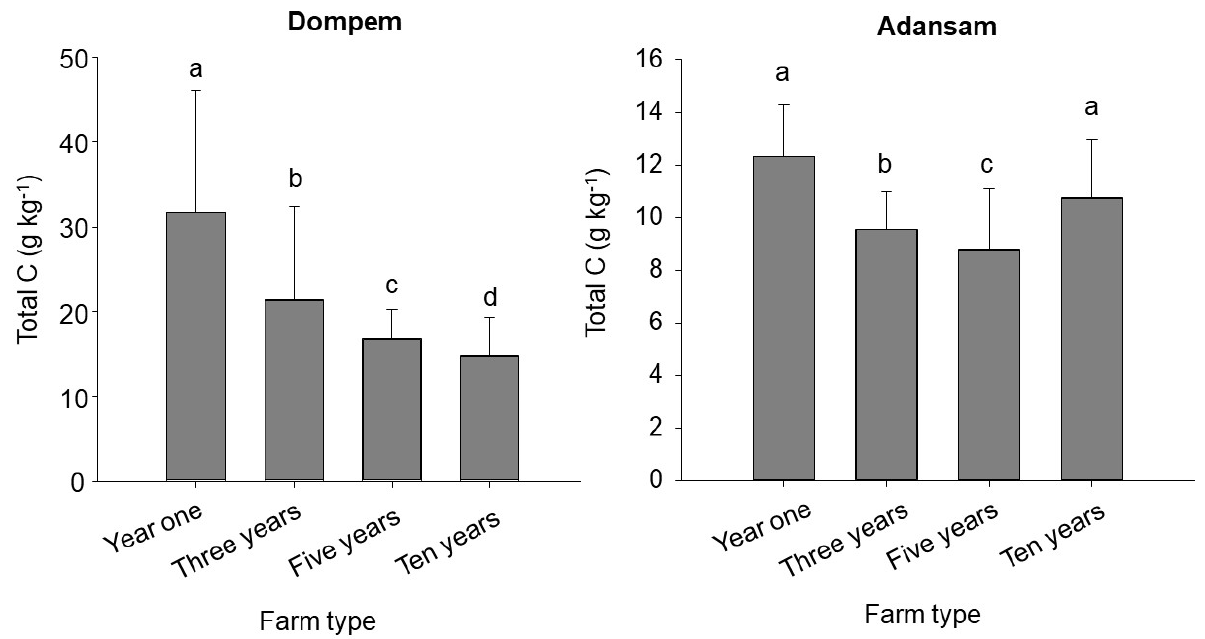
Figure 3. Mean total carbon content of soils from Dompem ( p = 0.001) and Adansam ( p = 0.001) ( n = 9 + one Standard deviation) and Adansam ( n = 11 ± one Standard deviation).